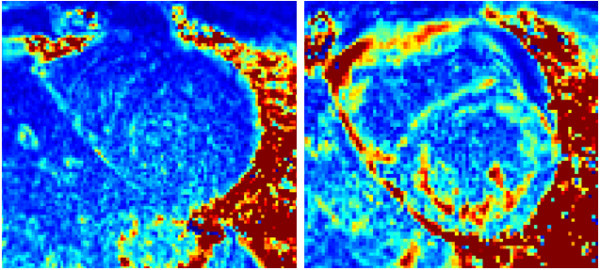
Example SD maps for illustrating cases with increased error due to uncorrected motion of varying severity. Uncorrected motion tends to cause local errors in the SD map which are readily recognized due to appearance of anatomical structure. The SD maps serve as an indication of T1-map quality.